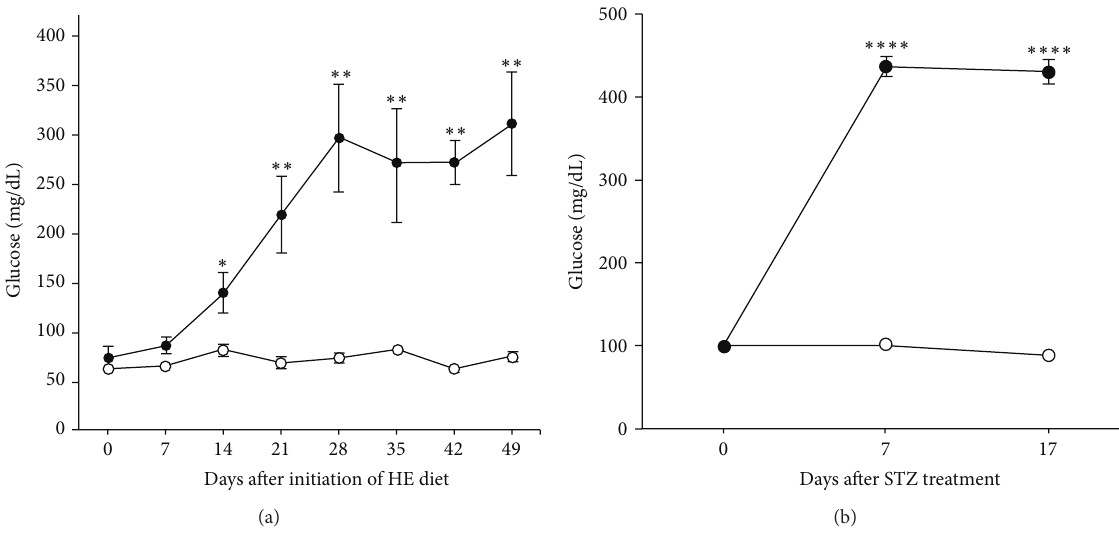
Figure 1: Blood glucose levels in PO and SPD rats after diabetes induction. (a) Gradual increase of blood glucose concentrations after induction of type 2 DM in PO rats by HE diet (full circles). Mild hyperglycemia of approximately 300 mg/dL was observed after 4 weeks and remained stable thereafter as opposed to normoglycemic control animals (empty circles) ( ∗ 𝑃 = 0.01 , ∗∗ 𝑃 < 0.01 ). (b) Severe stable hyperglycemia around 450 mg/dL was established one week after single STZ treatment of SPD rats (full circles) as opposed to untreated animals (empty circles) ( ∗∗∗∗ 𝑃 = 0.00001 ). Data are presented as mean ±